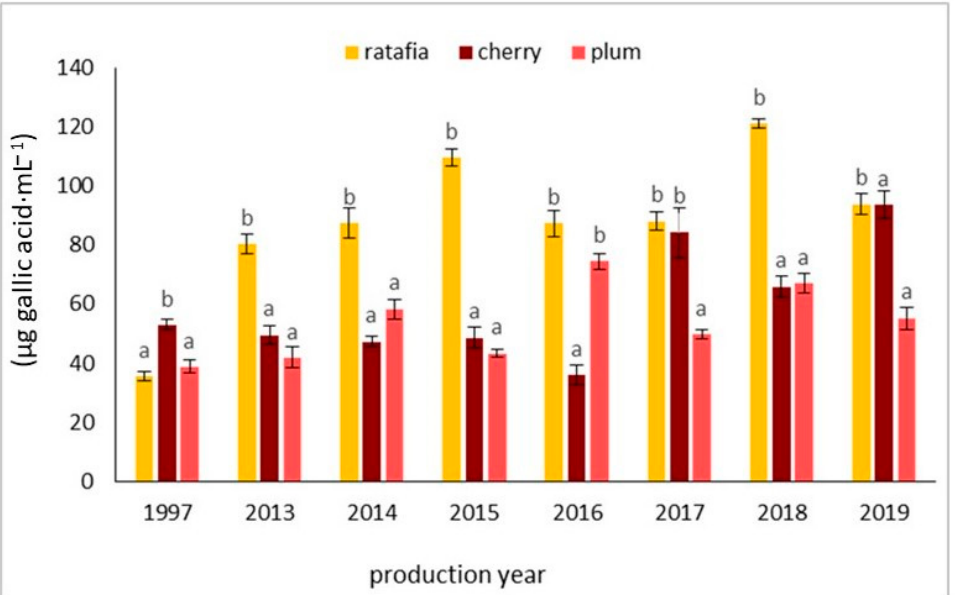
Figure 10. The content of gallic acid in three types of nalewkas in 1997 and 2013–2019. Values are the mean of three determinations (n = 3). Different letters indicate significant differences between all types of nalewka in individual years ( α = 0.05).